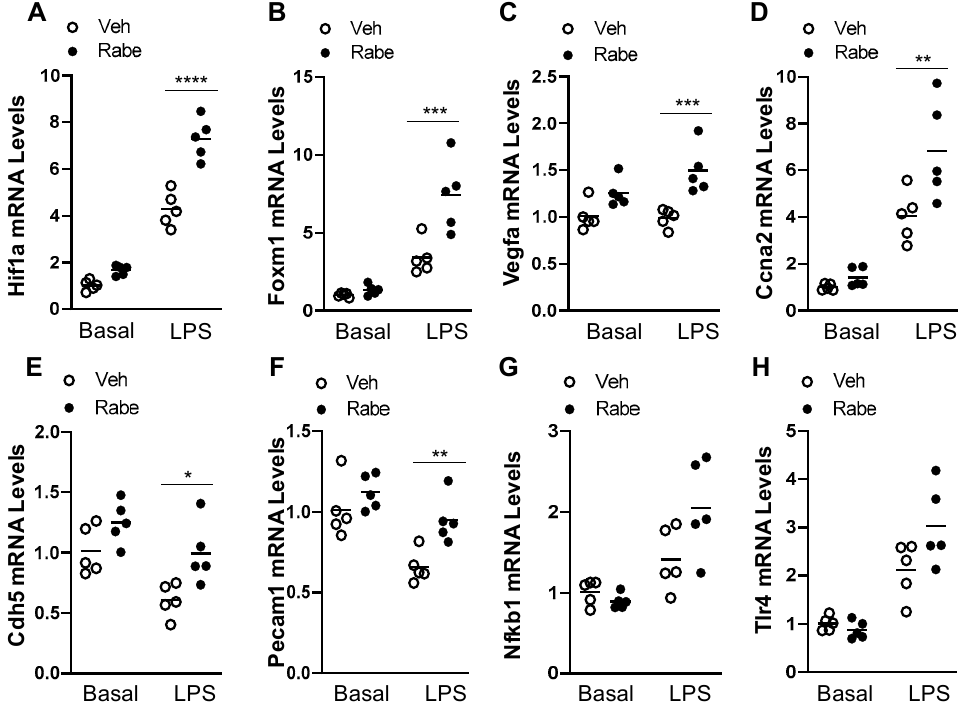
Figure 5. Rabeprazole promotes HIF1 α /FoxM1 signaling after LPS challenge. ( A – H ) WT mice received PBS vehicle (Basal) or LPS (2.5 mg/kg, i.p.). At 4 and 20 h post-LPS, mice were treated with PBS vehicle (Veh) or Rabeprazole (Rabe, 18 mg/kg, oral). At 48 h post-LPS, lung tissues were collected for RNA isolation and quantitative RT-PCR analyses of various genes. * p < 0.05, ** p < 0.01, *** p < 0.001, and **** p < 0.0001. Two-way ANOVA with Sidak’s post-tests.